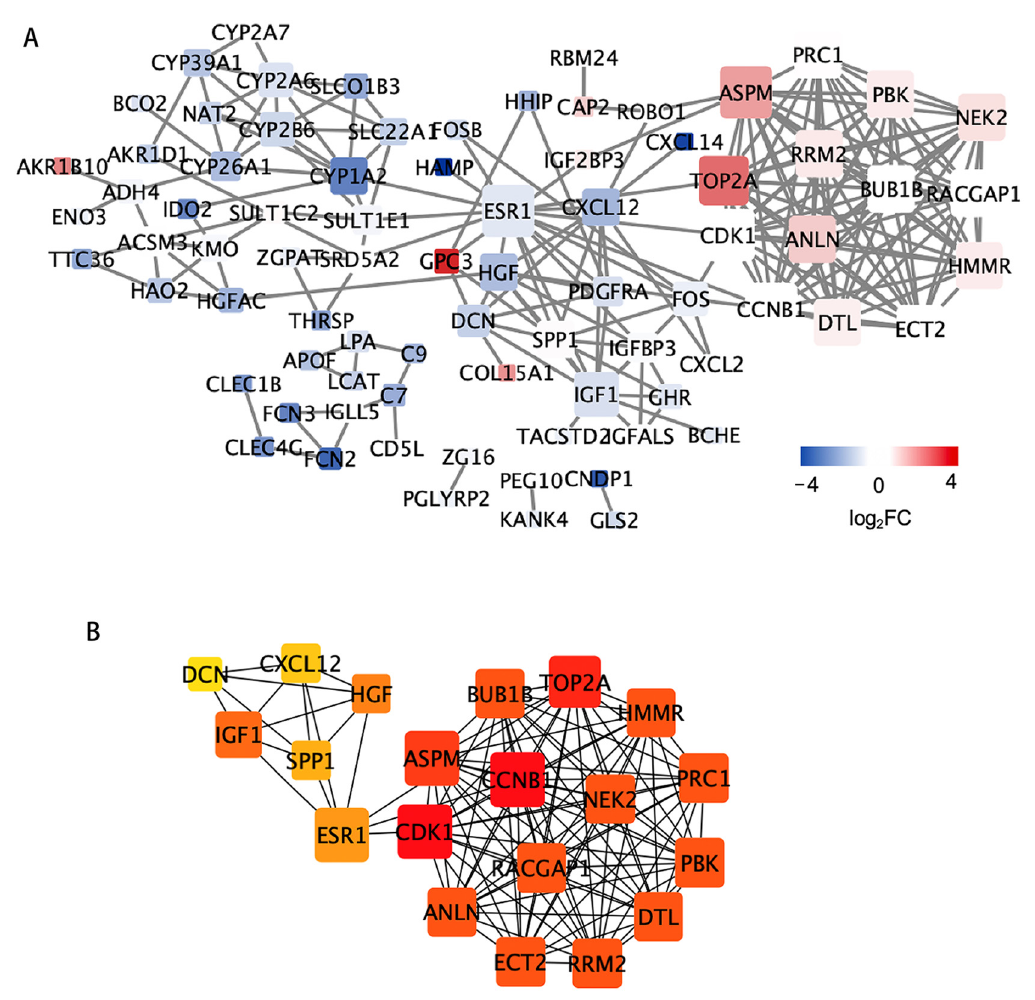
Figure 4. PPI network and module analysis. PPI network construction for candidate genes using STRING11.0 was visualized using Cytoscape ( A ). The size of the node refers to the degree standard, and the color of the node represents the values of log 2 FC. The network directly associated with the top 20 hub genes identified using CytoHubba ( B ). The color depth of the nodes represents their importance in the network.